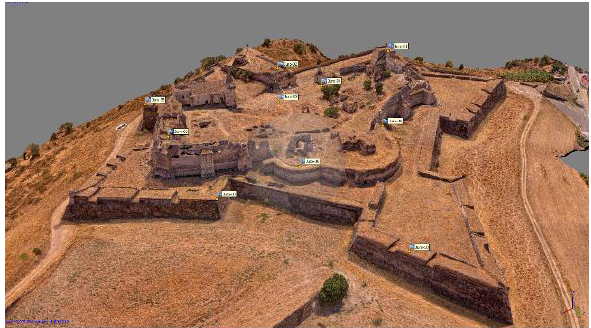
Figure 5. Global model with externally oriented with GPS points.